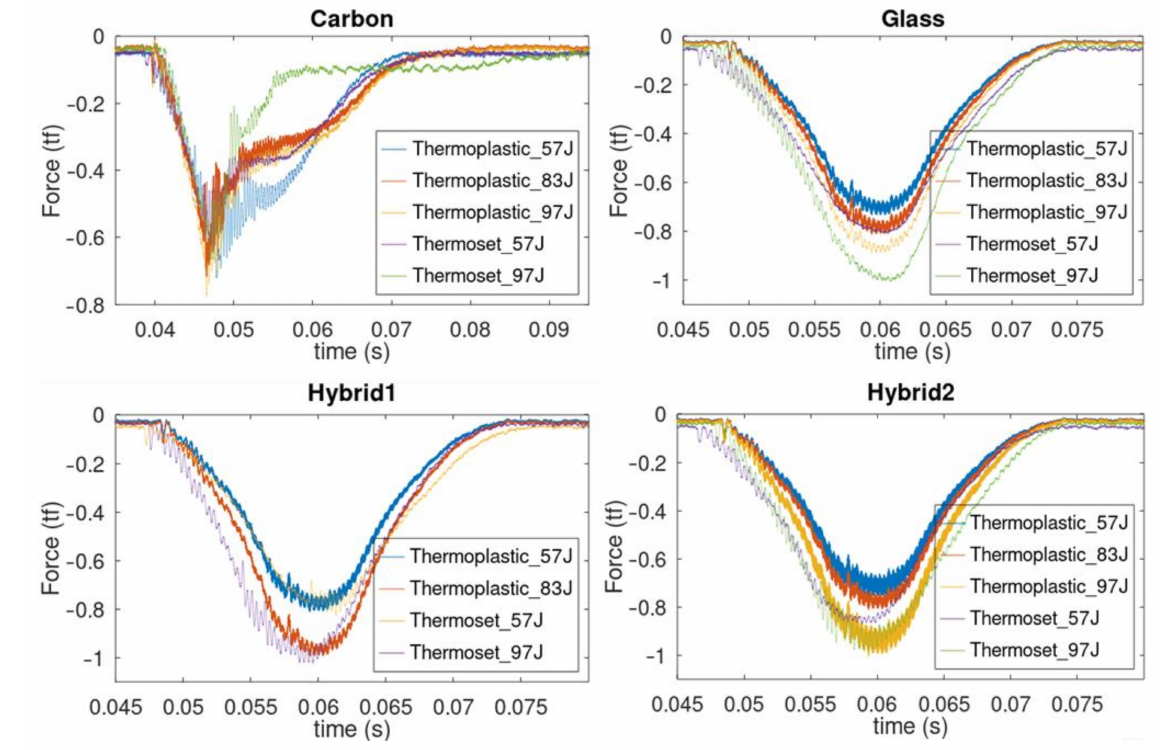
Figure 12. Experimental impact forces measured for Elium (thermoplastic) and Epoxy (thermoset) at different energy levels.